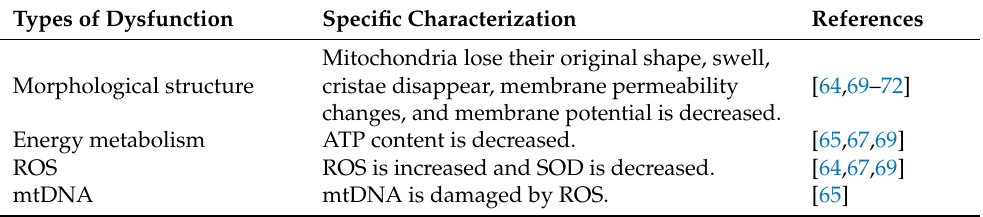
Table 5. Characterizations of mitochondrial dysfunction in viral hepatitis. Types of